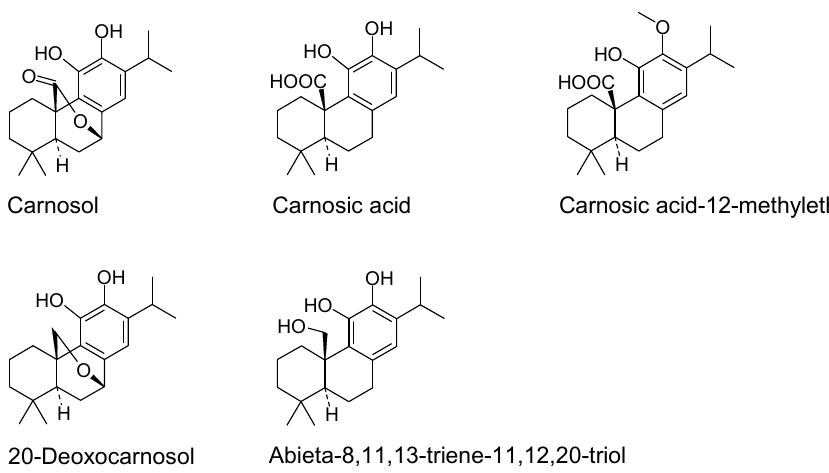
Figure 1. Structures of the abietane diterpenes used in this study.